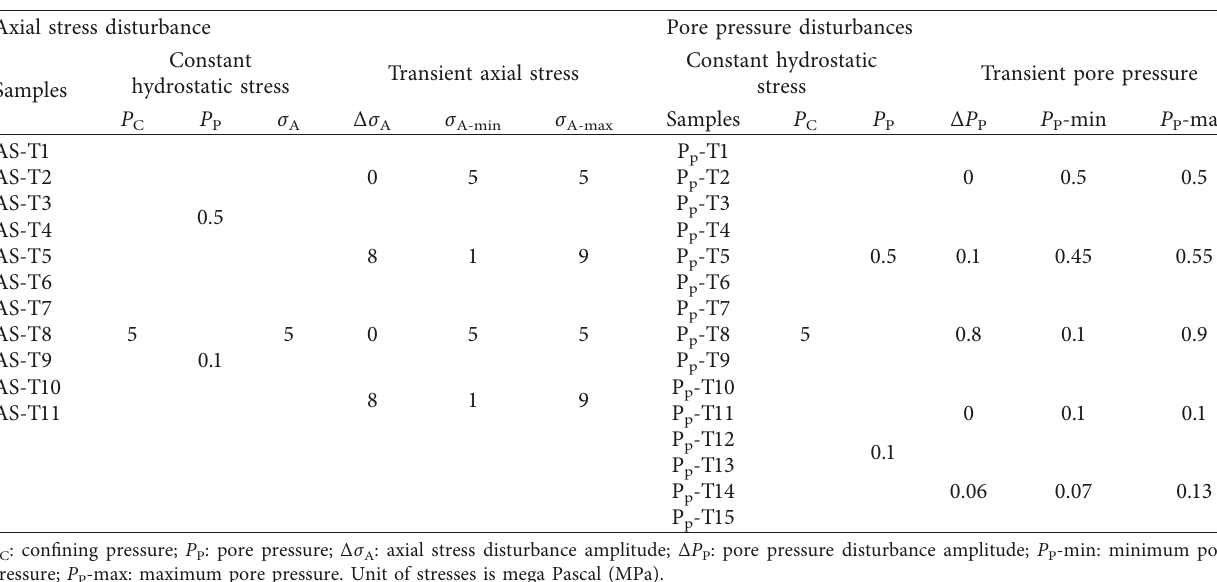
Table 5: Experimental condition for the Shikotsu welded tuff.